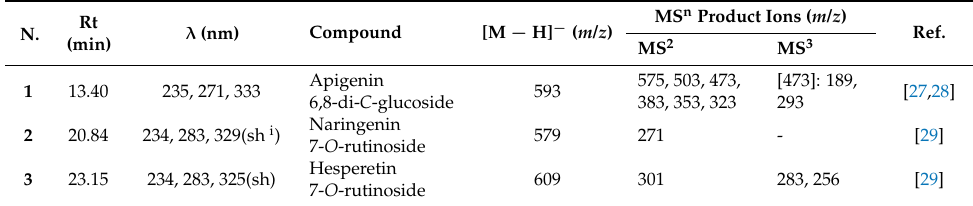
Table 1. Major phenolic compounds found in fresh, TP, and HPP orange juices and the corresponding MS n fragmentation profile.